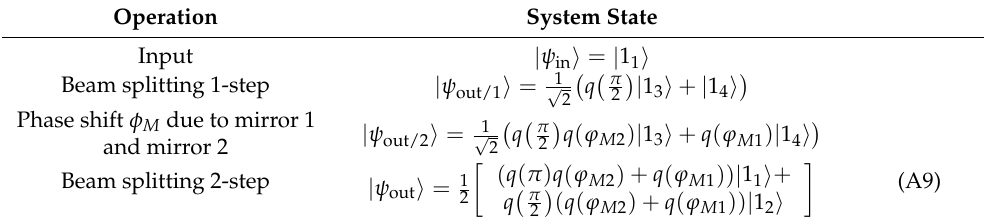
Table A3. Preparation of the quantum state at the interferometer.